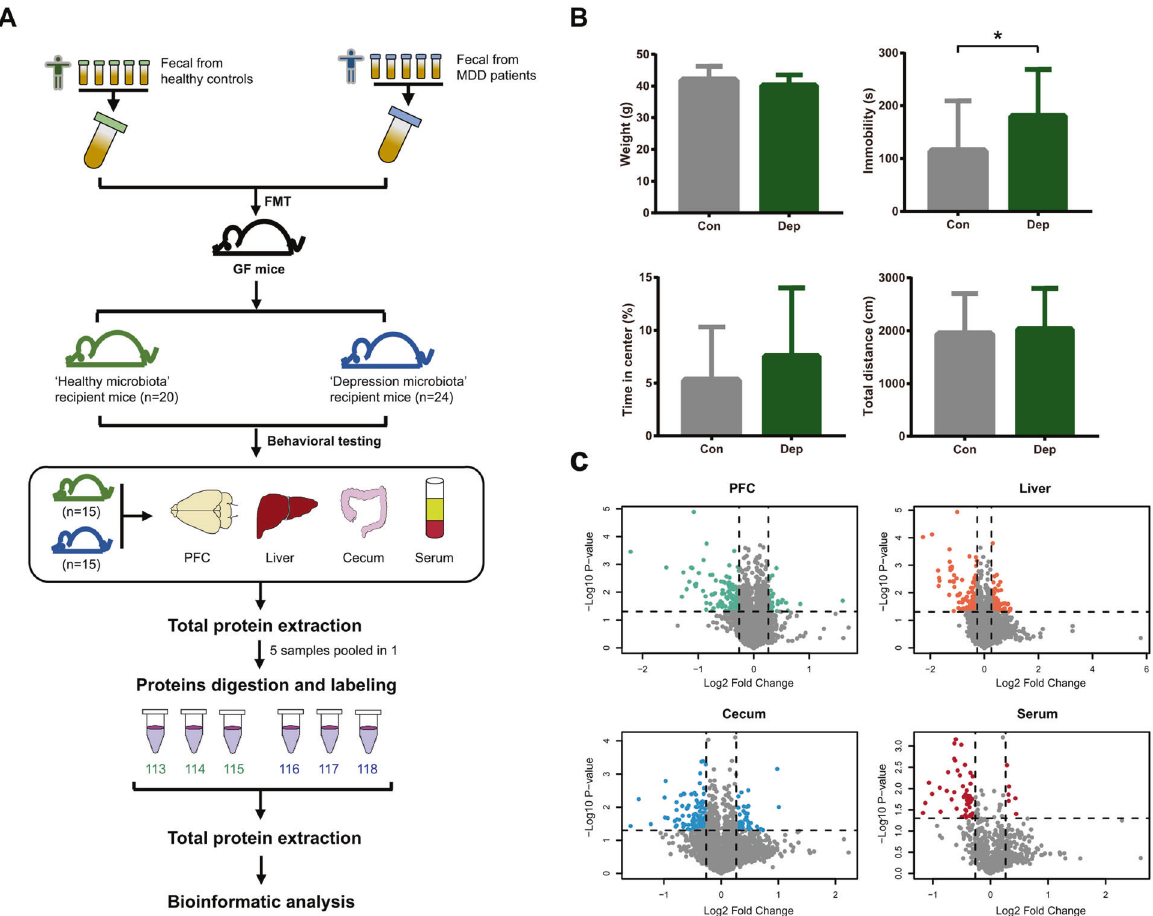
Fig. 1 Work fl ow of this study. A Experimental and proteomics work fl ow of the study. B There were no differences in weight, total motion distance, and percentage of time spent in the center of the OFT between “ depression microbiota ” and “ healthy microbiota ” recipients. The “ depression microbiota ” recipients displayed an increased duration of immobility in the FST compared with “ healthy microbiota ” recipients (* p < 0.05, t test). The gray bars indicate the “ healthy microbiota ” recipients ( n = 20). The green bars indicate the “ depression microbiota ” recipients ( n = 24). C Volcano plots of detected protein abundance from the four tissues. Green, orange, blue, and red dots indicate DE proteins in the PFC, liver, cecum, and serum,